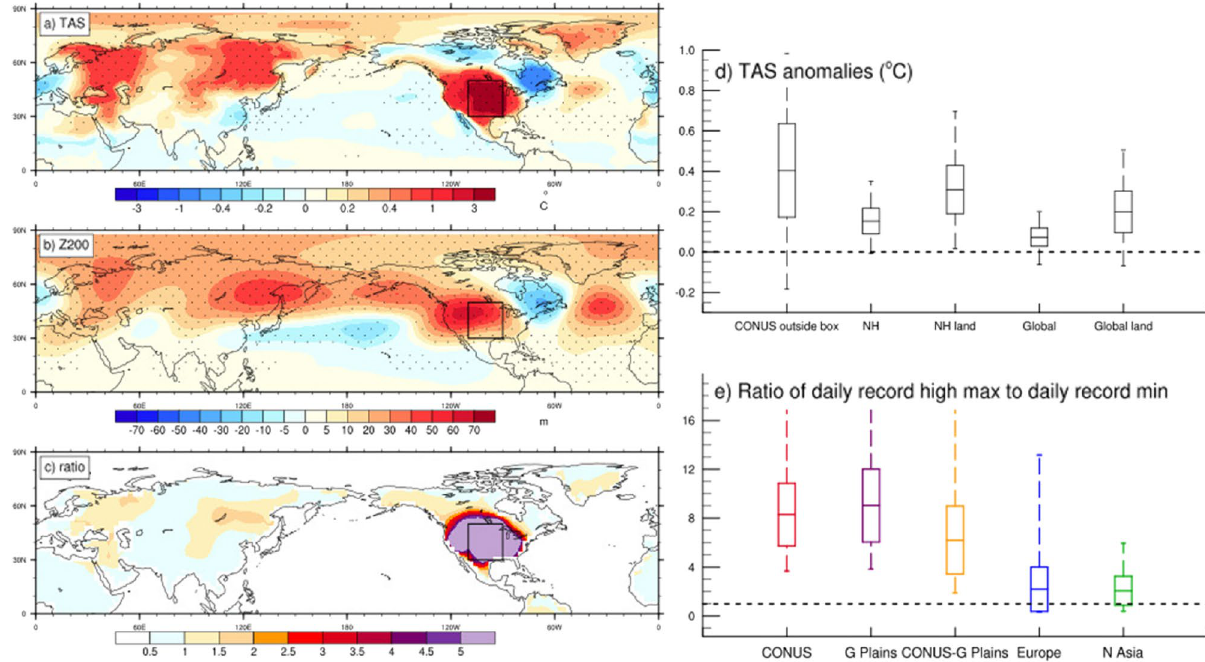
Figure 3. Dust Bowl heat extremes in the model experiment. The MJJA season average anomalies, experiment minus control, from the climate model sensitivity experiment where soil moisture over the Great Plains box (denoted in panels a-c ) is set to zero; stippling indicates differences significant at the 95% level; ( a ) surface air temperature (TAS, °C); ( b ) 200 hPa height (Z200, m); ( c ) total records ratio differences; ( d ) box and whisker plots (markings indicate maximum value, + 1 standard deviation, mean, − 1 standard deviation, minimum value) for TAS anomalies (°C) for continental U.S. (CONUS) averaged outside the Great Plains box; NH (Northern Hemisphere), NH land (Northern Hemisphere land grid points), global average, global average over land grid points; ( e ) total records ratios averaged over various regions taken from the data shown in ( c ) for continental U.S. (CONUS), Great Plains, Great Plains minus CONUS, Europe (10° W–60° E, 30° N–50° N), and Northern Asia (80° E–160° E, 35° N–75° N) with box and whisker markings as in ( d